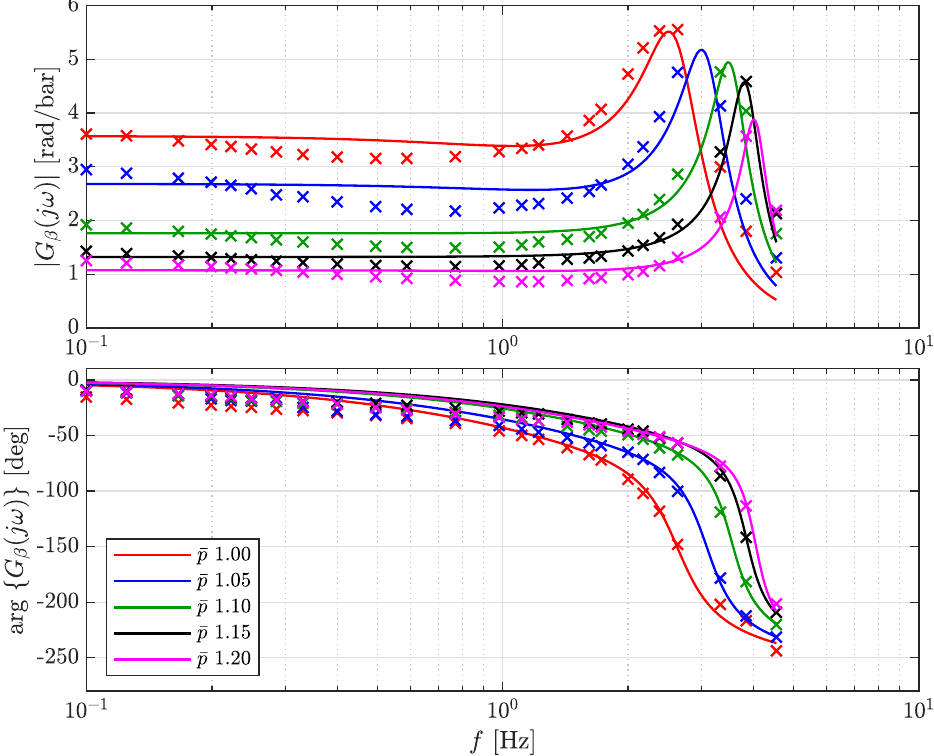
Figure A1. The frequency response in β -direction for different lower pressure levels ¯ p with the magnitude in the top plot and the phase in the bottom plot. The measured frequency responses resulting from the identification experiments are indicated by the crosses and the corresponding fits by the solid